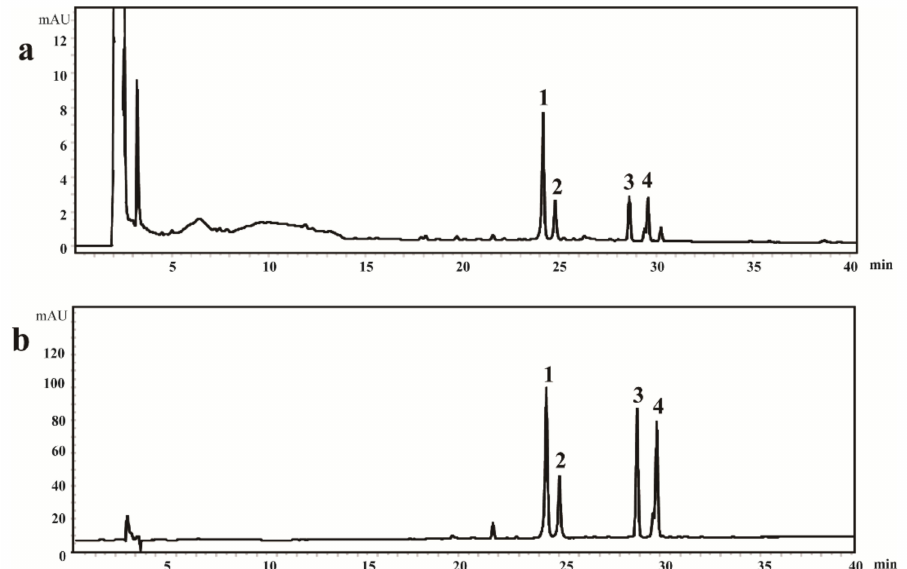
Figure 1. The typical HPLC chromatograms of: ( a ) Dioscoreae Nipponicae Rhizoma sample and ( b ) four steroidal saponins reference standards. (1. protodioscin, 24.15 min; 2. protogracillin, 24.77 min; 3. pseudoprotodioscin, 28.60 min; and 4. Pseudoprotogracillin, 29.56